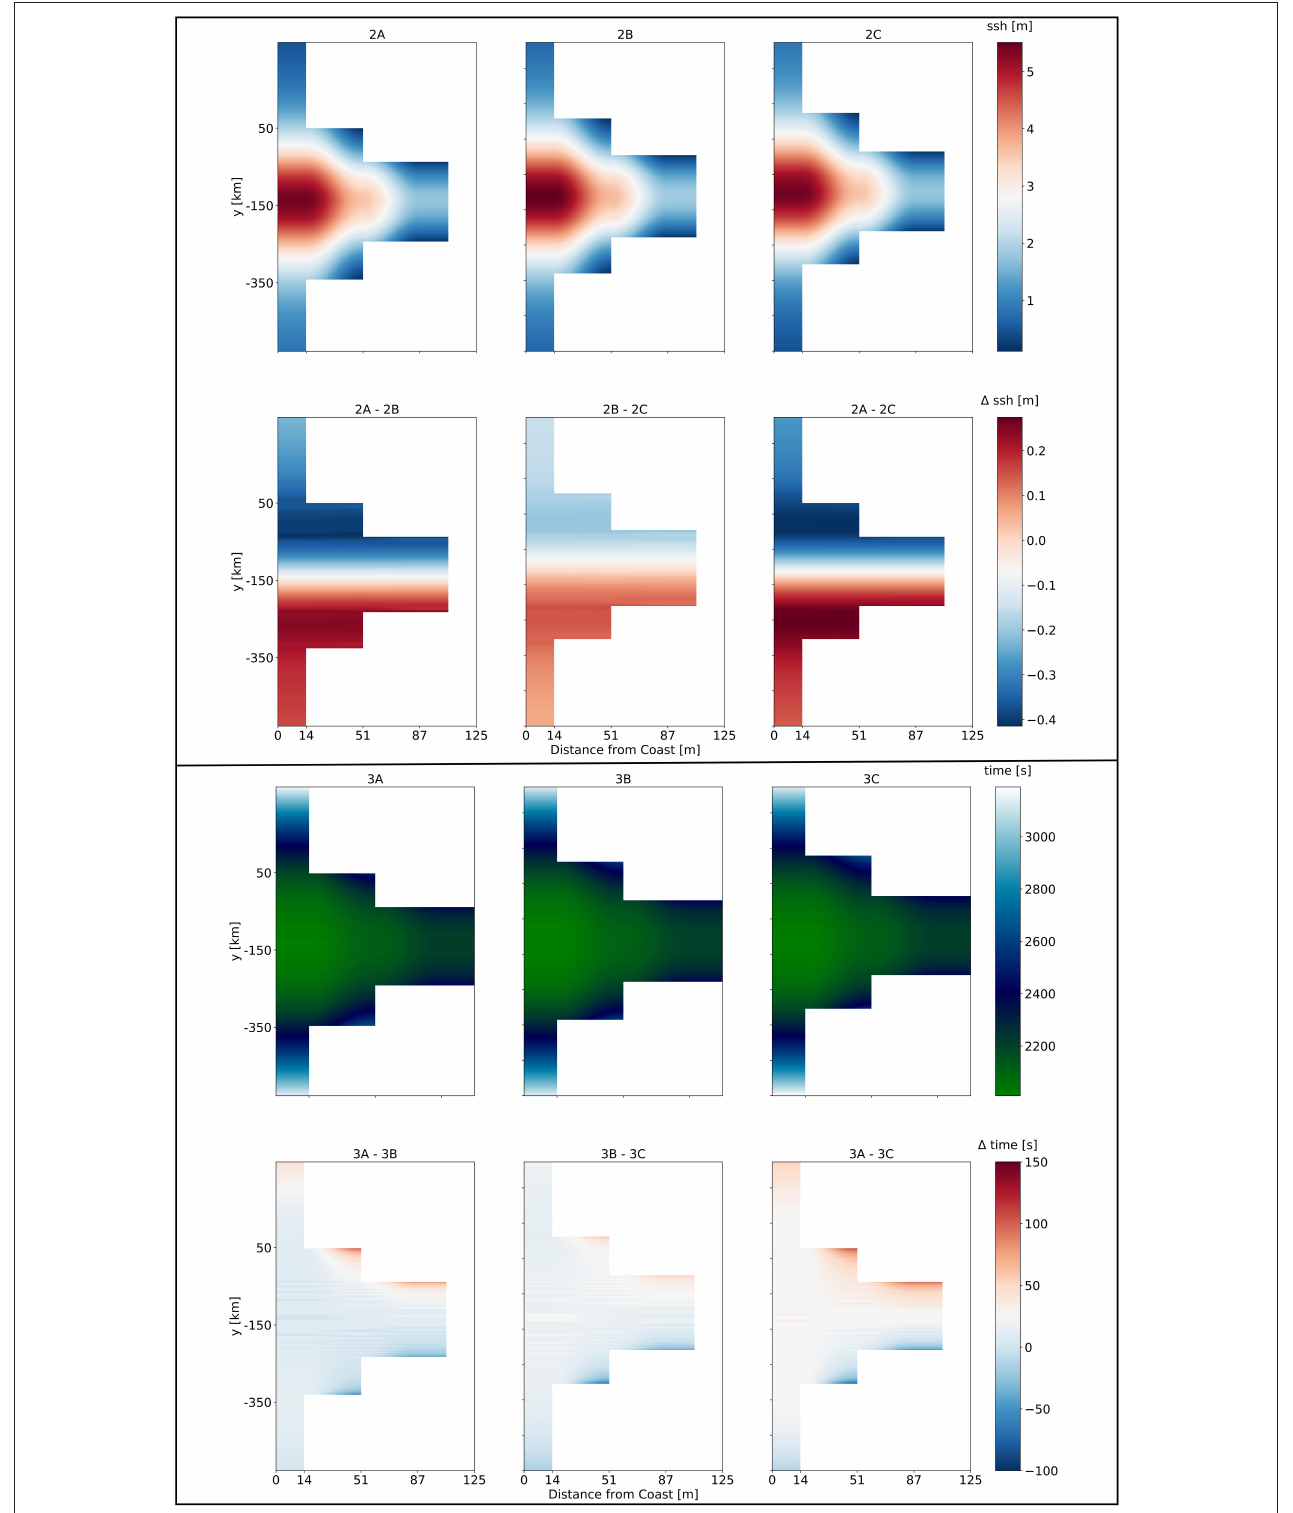
FIGURE 7 | (Top) Comparison of sea surface height (ssh) for tsunami fronts arriving at the coast for the models 2A–2C (upper row). The difference in arrival times between the models is shown as 1 ssh (lower row). (Bottom) Inundation comparison for models 3A–3C. The green to white color scale shows the time delay for the tsunami fronts arriving at the coast (upper row). The difference in inundation between respective models is plotted as 1 t (lower row).